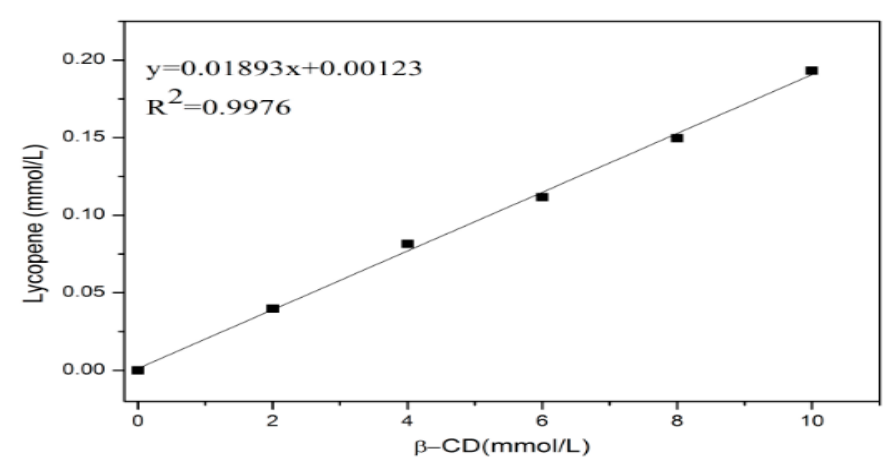
Figure 4. Phase-solubility diagram of lycopene in the presence of β -CD.